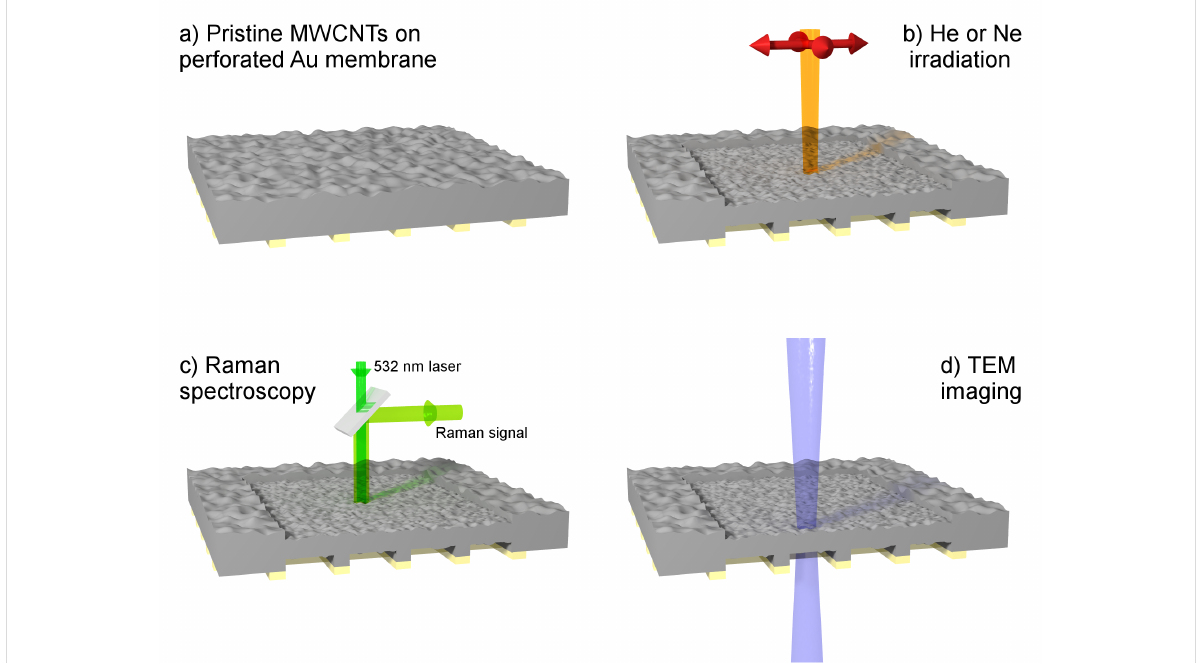
Figure 8: Schematic illustration of the sample configuration and the sequence of techniques used in this investigation: a) deposition of MWCNTs in a perforated Au TEM grid, b) irradiation with He + or Ne + ions with a fluence of 10 14 –10 18 ions/cm 2 , c) Raman spectroscopy in the irradiated area with a 532 nm laser, and d) TEM analyses in the irradiated area.